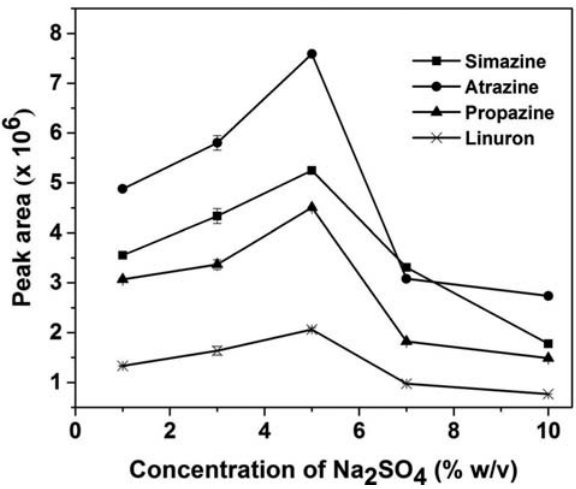
Figure 1b. Effect of concentration of salt on the extraction of selec- ted herbicides